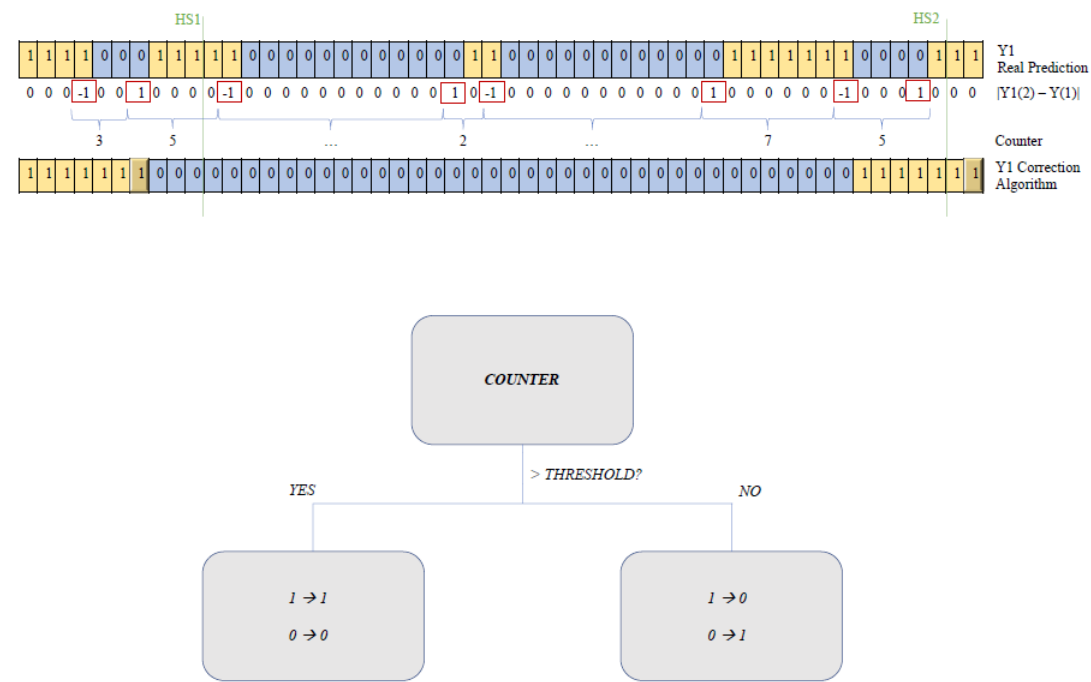
Figure 5. Correction algorithm: isolated short (counter < threshold) clusters were corrected according to the surroundings, as schematically reported in the bottom diagram.